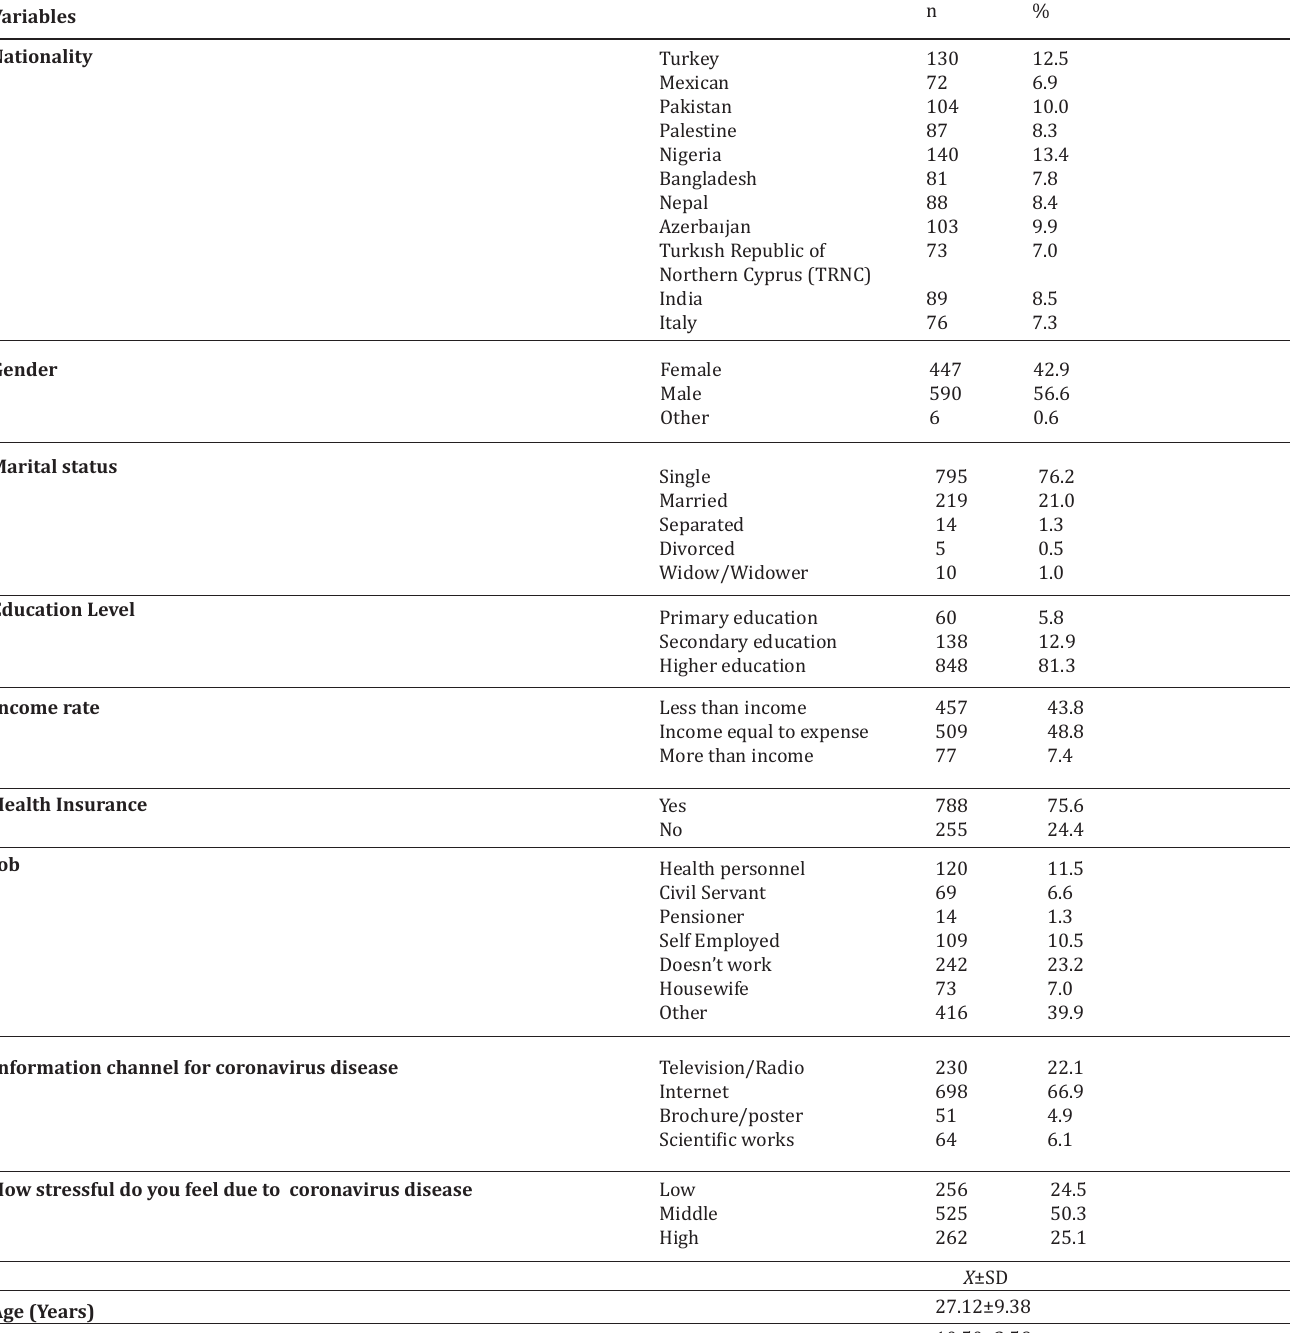
Table 1 The demographic characteristics of the respondents’ (N =